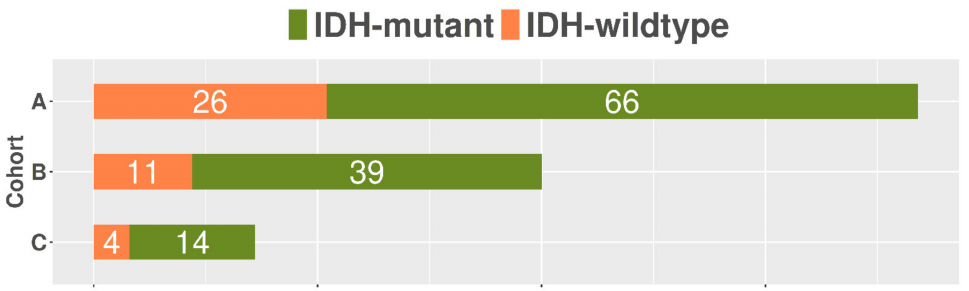
Figure 5. Distribution of the isocitrate dehydrogenase (IDH) status across the three examined centers. Numbers of total IDH-mutant and IDH-wildtype statuses from each clinical center are shown in white.